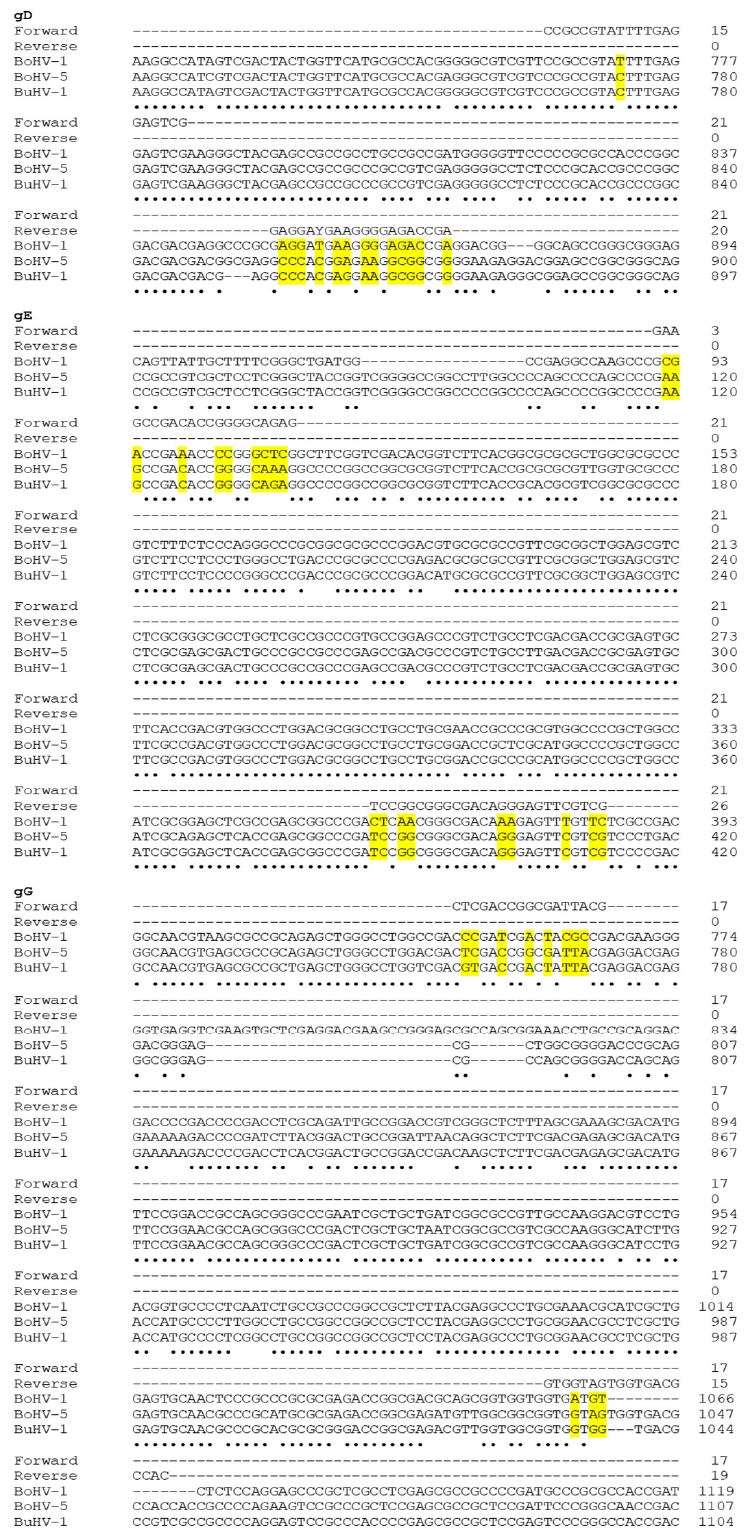
Figure 1. DNA sequence alignment for the portions of gD, gE and gG genes identified as targets to discriminate BuHV-1, BoHV-1 and BoHV-5. The symbol ‘•’ indicates monomorphic nucleotides. The yellow shadings indicate the polymorphic nucleotides (SNPs) at the primer attachment sites. The number of bases depicted in each line is marked by the number shown at the